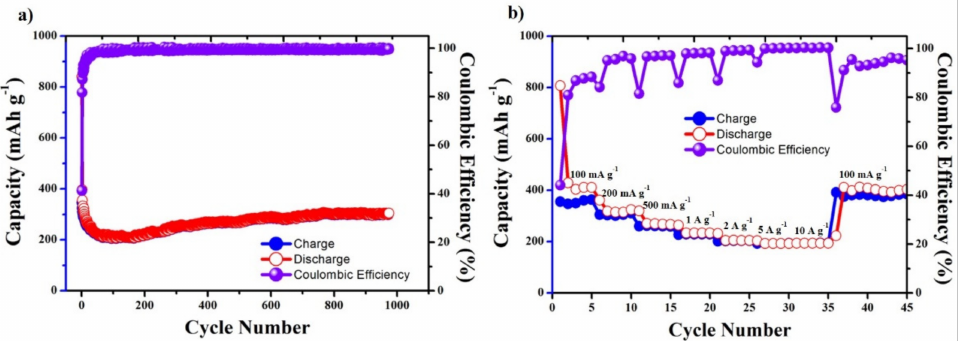
Figure 8. ( a ) Cyclic performances of the MnO 2 -CNC nanocomposite electrodes at 100 mA g − 1 and ( b ) Rate performance of MnO 2 -CNC nanocomposite electrodes at various current densities ranging from 0.01 V to 3